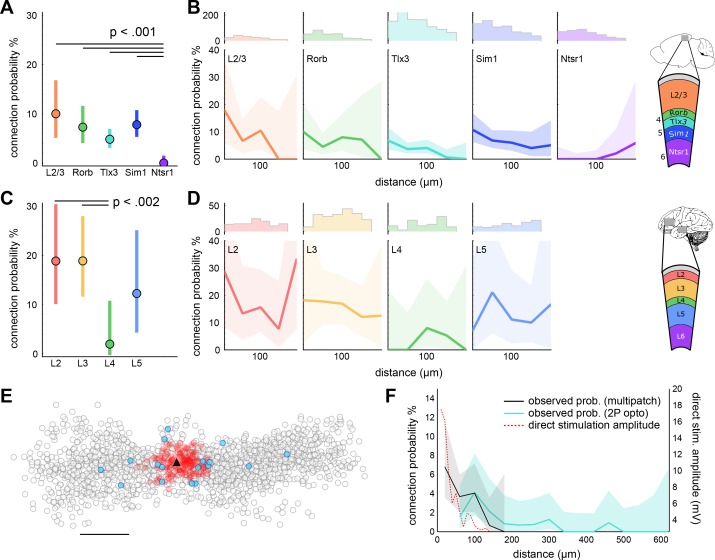
Distance dependent connectivity profiles of mouse and human E-E connections.(A) Recurrent connection probability and distribution of connections for mouse -linesand layer 2/3. Mean connection probability (filled circles) and 95% confidence intervals (bars) for connections probed within 100 µm (n connections in Table 1). (B) Connection probability over distance for mouse Cre-lines and layer 2/3. Top: Histogram of putative connections probed. Bottom: Mean connection probability (thick line) with 95% confidence intervals (shading) binned in 40 µm increments. (C) Like-to-like connection probability and distribution of connections between human pyramidal neurons. Mean connection probability (filled circles) and 95% confidence intervals (bars) for connections probed within 100 µm. (D) Connection probability over distance for human pyramidal neurons, formatted as in panel B. (E) Tlx3-Tlx3 connection probability measured by two-photon mapping. X-Y distance distribution of connections probed onto a postsynaptic cell (black triangle), detected presynaptic neurons (filled circles), no connection detected (empty circles), and direct event artifact due to undesired activation of opsin in the dendritic arbor of the recorded cell (red circles). (F) Connection probability and stimulation artifact over distance measured by two-photon mapping. Mean connection probability vs. distance (blue line; starting at 50 µm) with 95% confidence intervals (shading) and direct event artifact amplitude vs. distance (dotted red line) for Tlx3-Tlx3 connections probed with two-photon stimulation. See Figure 4—figure supplement 3 for distribution of connectivity as a function of cortical slice position and cell depth. See Figure 4—figure supplements 1,2 for details on two-photon connectivity experiments.10.7554/eLife.37349.017Figure 4—source data 1.Distance dependent connectivity profiles of mouse and human E-E connections.